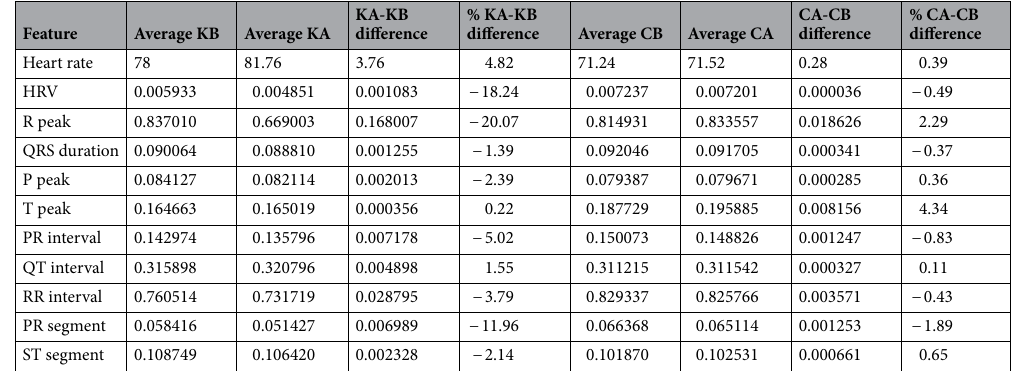
Table 2. Average ECG features of chewer and control subjects before and after chewing session.